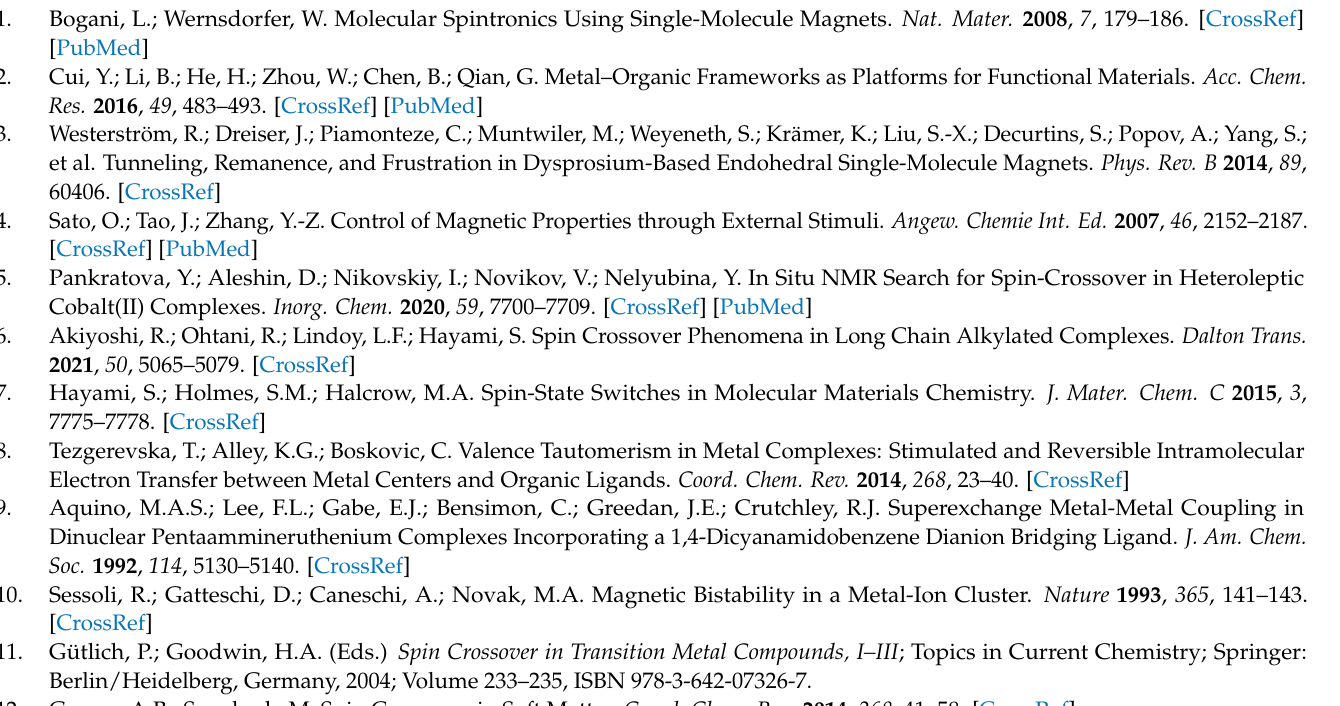
Figure S1—IR spectra, Figures S2–S9—PXRD data; Figures S10–S13—Crystal packing; Figure S14—Diffuse reflectance spectra; Figure S15—EPR spectra; Figures S16—AC magnetic data; Table S1—Continuous Shape Measures